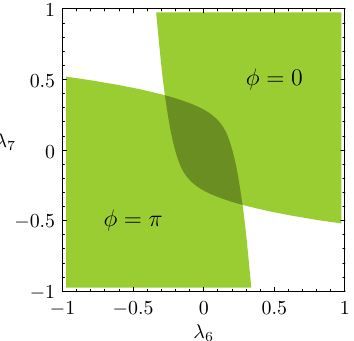
Fig. 3 The allowed region in the λ 7 vs. λ 6 plane for the 2HDM with no CP-violation is the intersection ( dark green ) of the regions with φ = 0 and φ = π ( light green ). Other parameters have values λ 1 = 0 . 125, λ = 0 . 25, λ = 0 . 25, λ = λ = 2 4 3 5